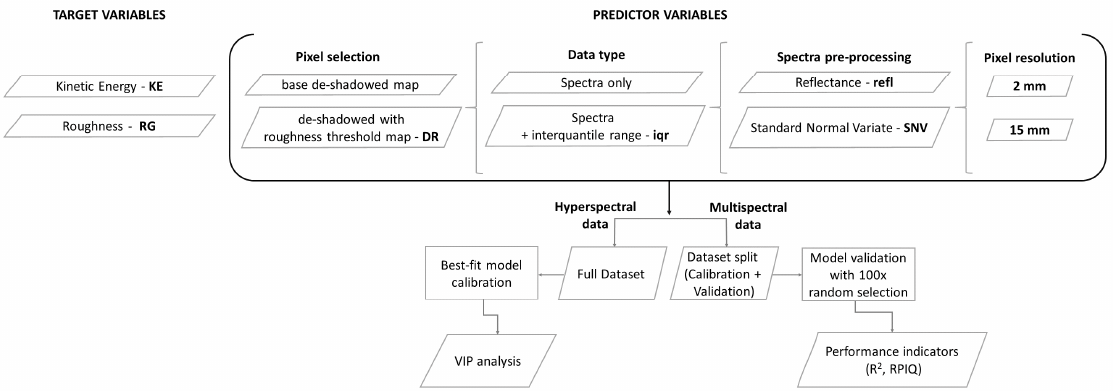
Figure 6. Flowchart of data selection and sub-setting for the PLSR modelling of multispectral data.